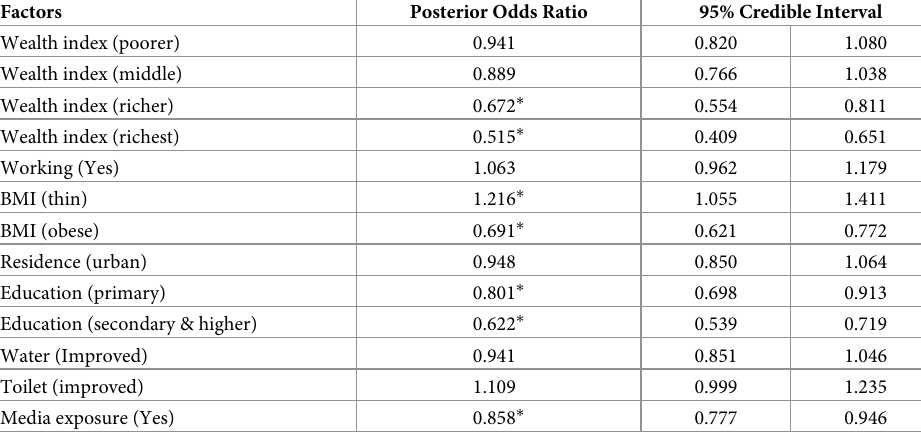
NB: The asterisked posterior Odds ratios are significant at the 5% level.